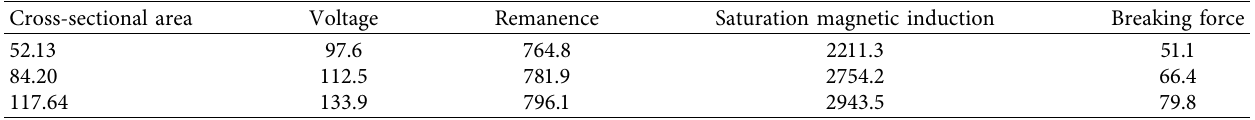
Figure 9: Sensor layout. Table 2: The relationship between the cross-sectional area of the test piece and the voltage.